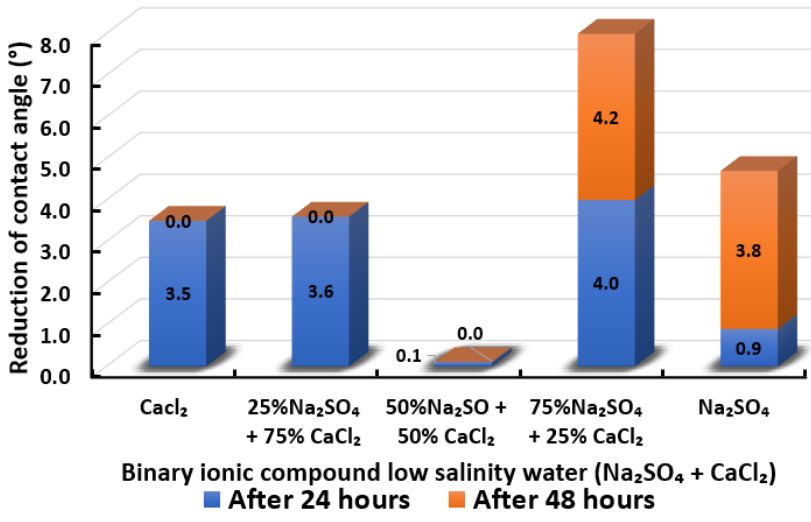
Figure 22. Contact angle reduction results for binary ionic compounds smart water (SW) solutions Na 2 SO 4 + CaCl 2 (3500 ppm).